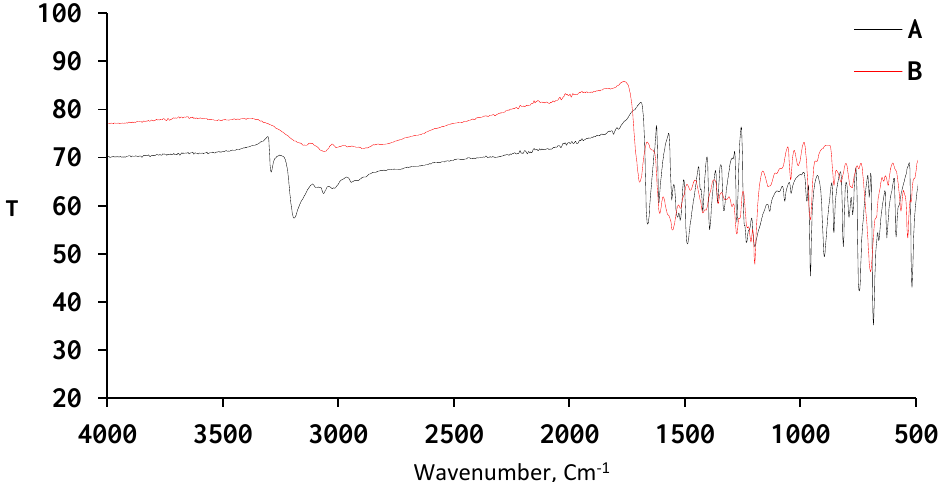
Figure 3. FT-IR spectra of (A) AMT and (B) [Cu(L)(NO 3 )(H 2 O) 2 ] • H 2 O. Table 1. FT-IR frequencies (cm −1 ) and tentative assignments of AMT and the Cu(II)-AMT complex.